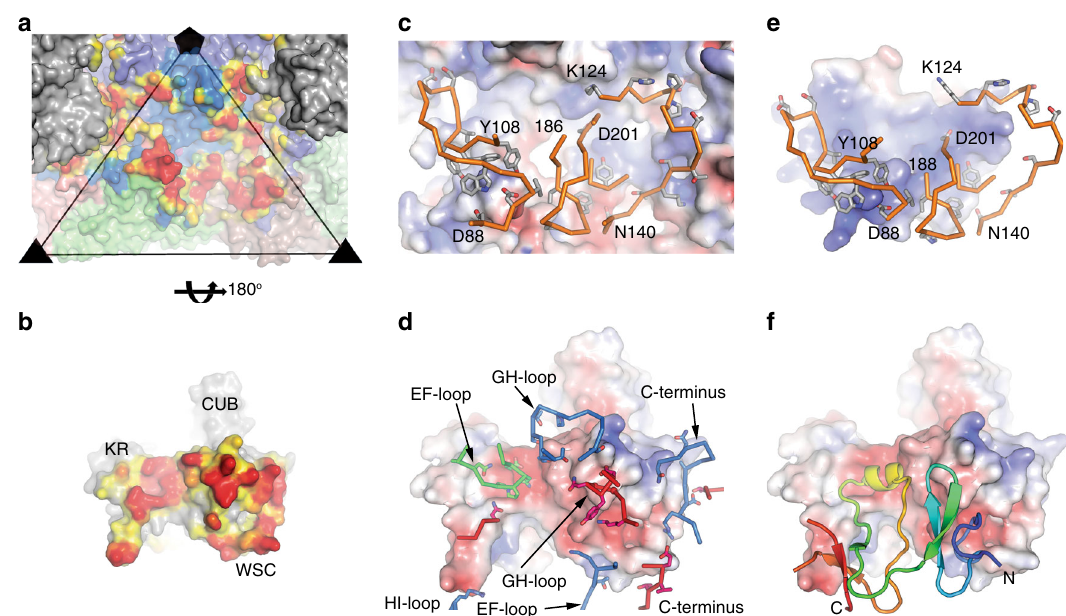
Fig. 3 The nature of the interactions between CV-A10 and KRM1 shown as open-book views. CV-A10 ( a ) and KRM1 ( b ) interface. Both virus and receptor are shown as surface representations. VP1, VP2 and VP3 of CV-A10 are coloured in pale blue, green and red, respectively and an icosahedral subunit outlined with the fi vefold (pentamer) and threefold (triangle) symmetry axes labelled, KRM1 from neighbouring subunits are shown in grey with domain names labelled in b . Contact areas between the virus and the receptor with distances ≤ 4.0 Å are shown in bright red, >4.0 Å and ≤ 9.0 Å in yellow. The contact areas attributable to two receptors bound at adjacent sites are shown in a . c , d Showing the contact areas on CV-A10 ( c ) and KRM1 ( d ) as electrostatic surfaces contoured at ±5 kT e − 1 (blue, positive; red, negative) with key residues from the interacting partner shown as sticks with main-chain backbones in orange and sidechains grey in c ; residues involved in contacts from the virus capsid VP1, VP2 and VP3 are shown as blue, green and red sticks, respectively in d . e , f Open-book view of electrostatic surfaces of interactions between KRM1 ( f ) and DKK1 ( e ). Residues that contact CV-A10 (sticks in e ) are also involved in interactions with DKK1 in the KRM1-DKK1-LPR6 complex. DKK1 is shown as ribbons in f